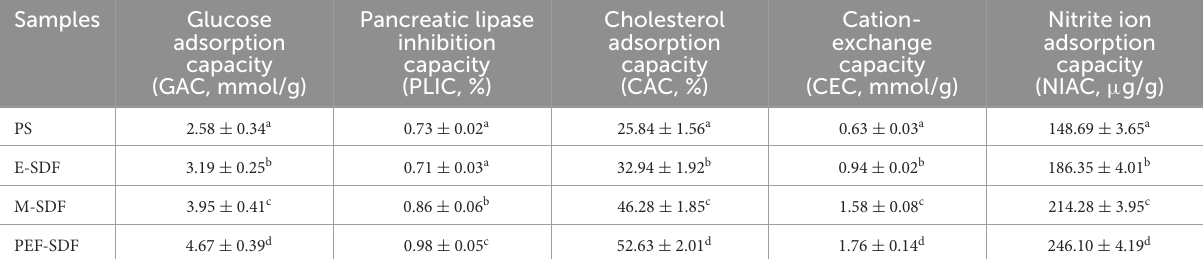
TABLE 3 The functional properties 1 of PS, E-SDF, M-SDF, and PEF-SDF.